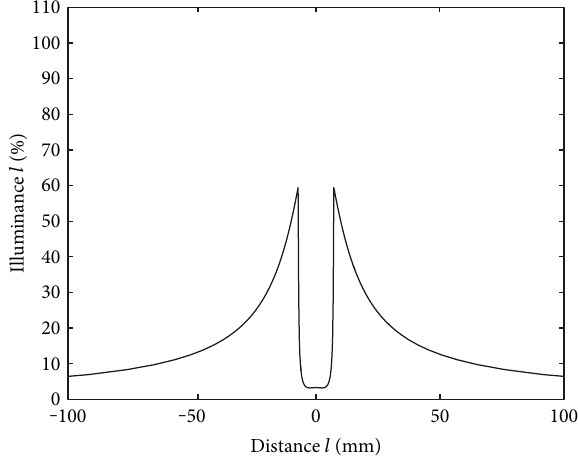
Figure 9: Distance-dependent backsheet re fl ection intensity. l =0 corresponds to the middle of the